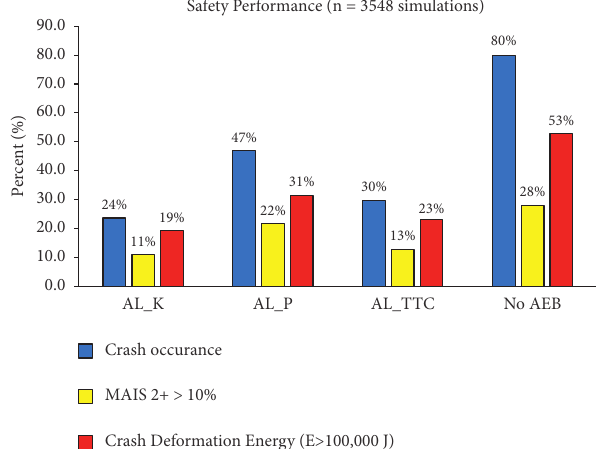
Figure 7: Measured safety performance based on the FCW/AEB